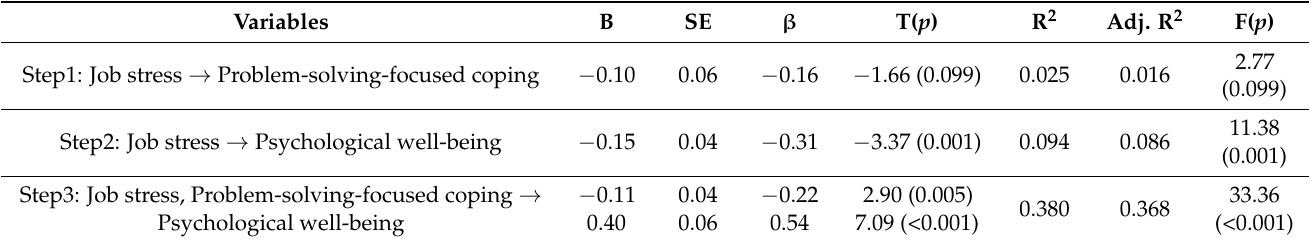
Table 4. Mediating effects of problem-solving focused coping in the relation between job stress and psychological well-being in participants.